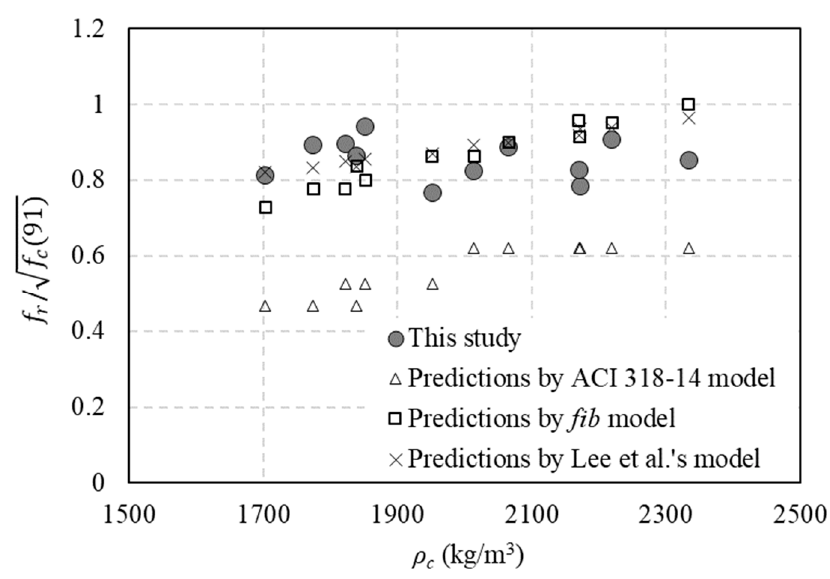
Figure 7. Effect of ρ c on the splitting tensile strength.